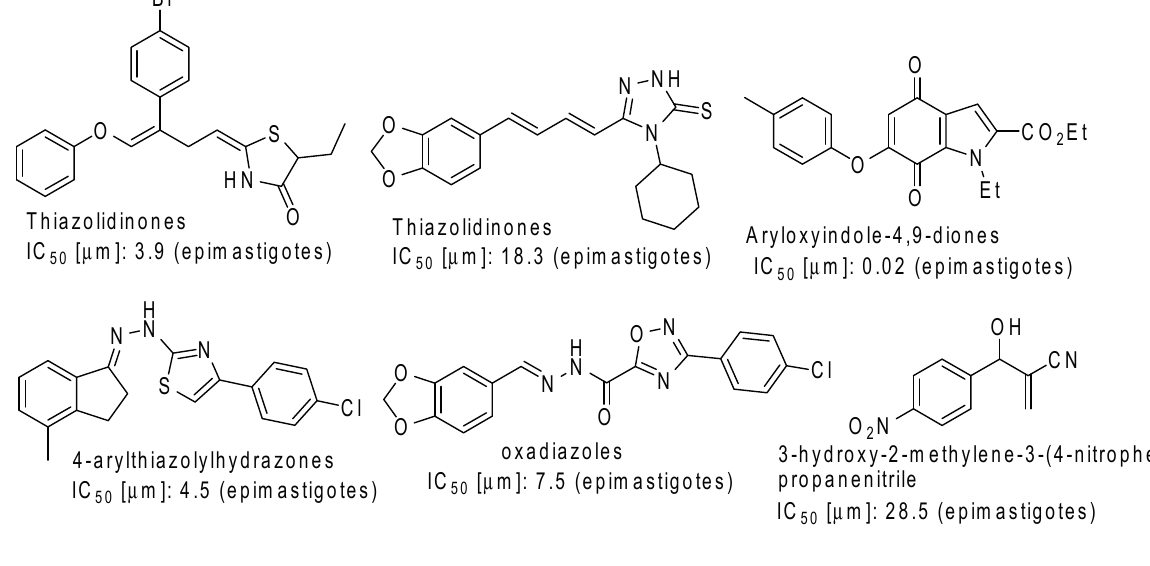
Figure 3. Compounds with anti- T. cruzi